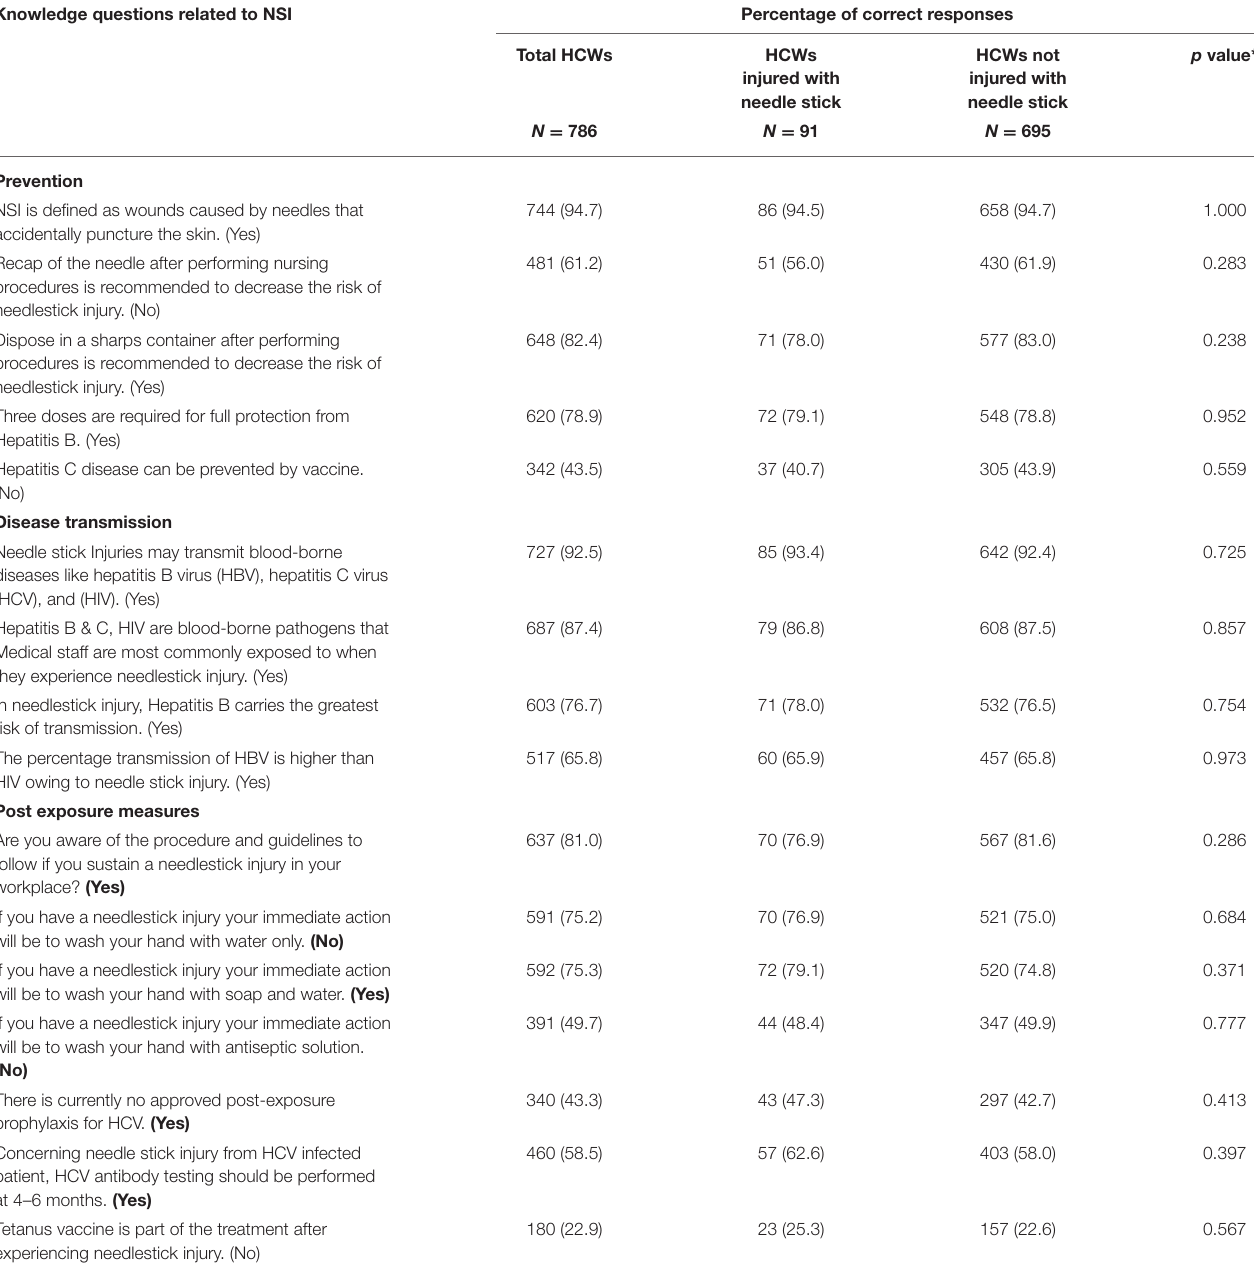
TABLE 4 | Percentages of correct responses to the knowledge questions related to